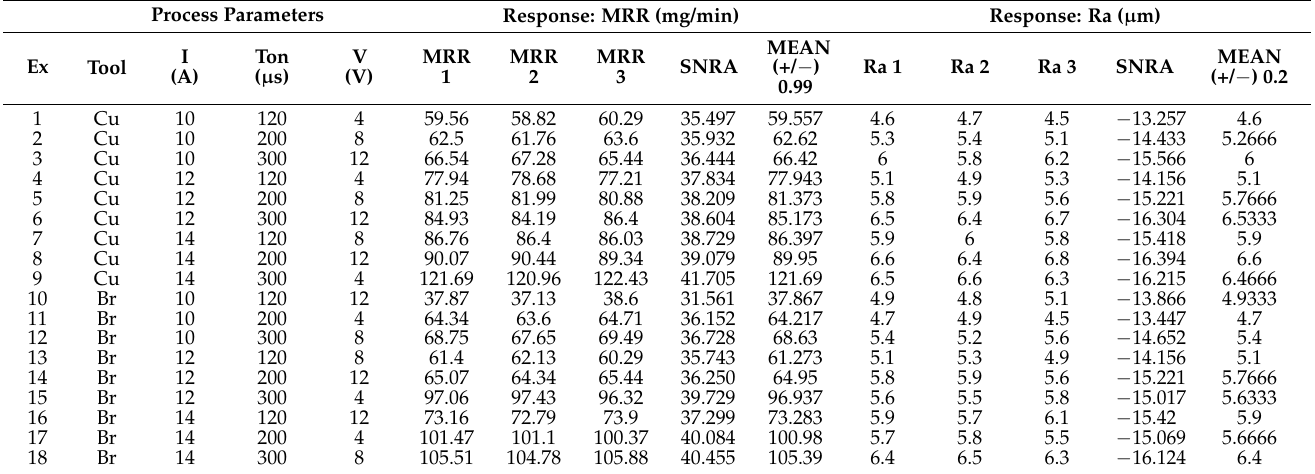
Table 4. Experimental results.